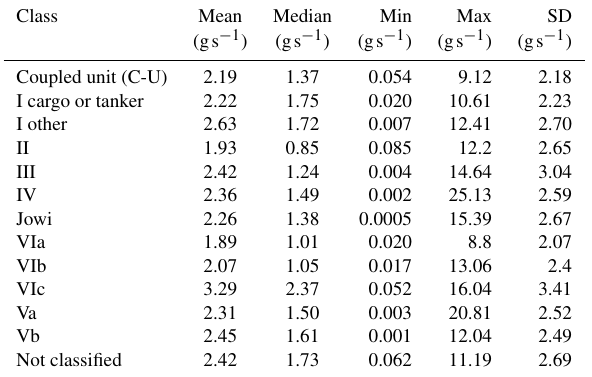
Table A2. Summary of data shown in Fig. 5. NO x emission rates for ships travelling downstream are derived from measurements at DURH.